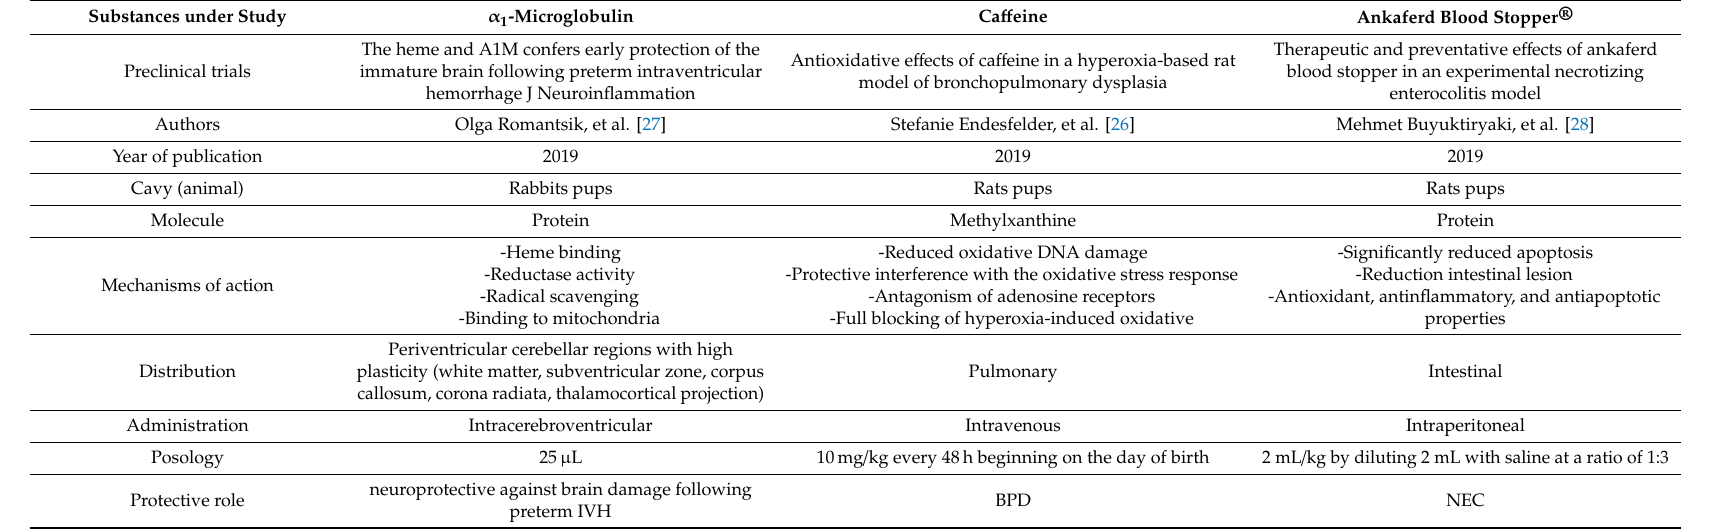
Table 2. Preclinical studies on Substances that prevent oxidative stress in